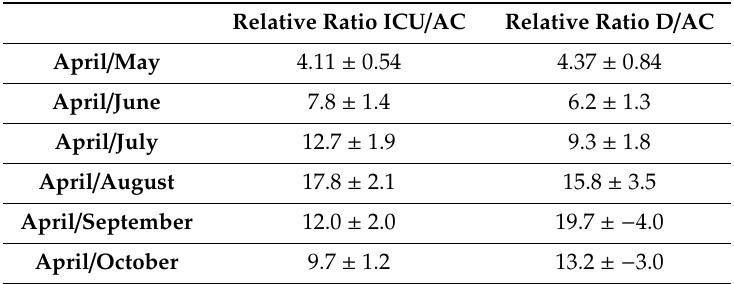
Table 2. Relative ratios ICU / AC and D / AC between April and following months. Indicated uncertainties are statistical errors computed at 95% probability level